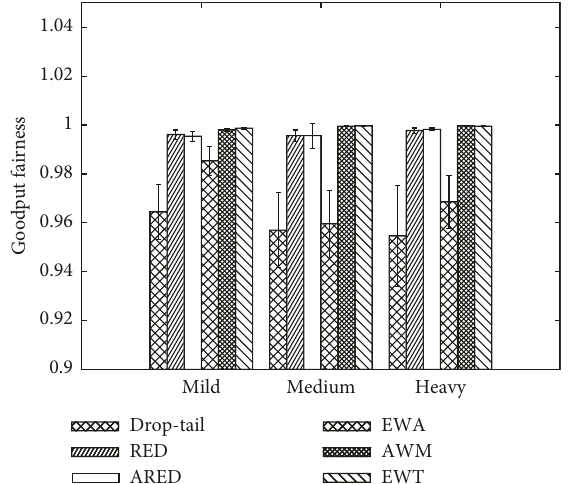
Figure 8: Goodput fairness: Scenario 1.